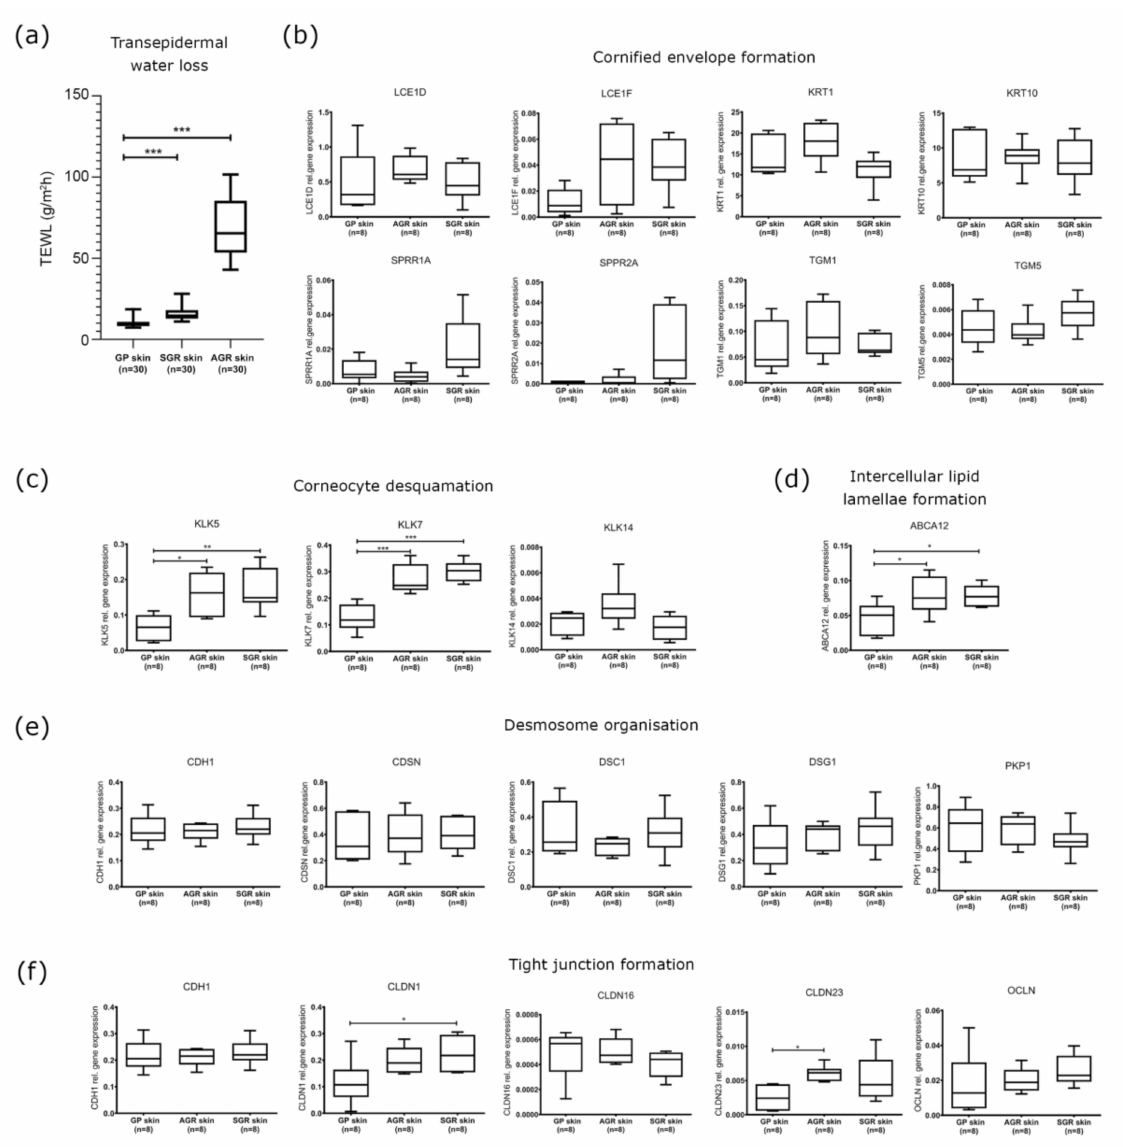
Figure 1. Different barrier functions and gene expression profiles of permeability barrier components characterize healthy GP, AGR, and SGR skin regions. ( a ) Transepidermal water loss levels in healthy GP, AGR, and SGR skin areas. Measurements were carried out with Tewameter TM300 (Courage and Khazaka, Cologne, Germany) on the flexural forearm, axilla, and forehead of healthy individuals ( n = 30). Gene expression of the components of ( b ) cornified envelope formation, ( c ) corneocyte desquamation, ( d ) intercellular lipid lamellae, ( e ) desmosome organization, and ( f ) tight junction formation in healthy GP, AGR, and SGR skin regions were examined by qRT-PCR. The graphs show the mean ± 95% confidence interval of measured mRNA transcript levels (* p < 0.05, ** p < 0.01, *** p < 0.001, determined by one-way ANOVA followed by Sidac post hoc test). Abbreviations: ABCA12, ABC transporter 12B; AGR, apocrine gland-rich; CDH, cadherin; CDSN, corneodesmosin; CLDN, claudin; DSC, desmocollin; DSG, desmoglein; GP, gland-poor; KLK, kallikrein-related peptidase; KRT, keratin; LCE, late cornified envelope; OCLN, occludin; PKP, plakophilin; SGR, sebaceous gland-rich; SPRR, small proline-rich protein; TEWL, transepidermal water loss; TGM,